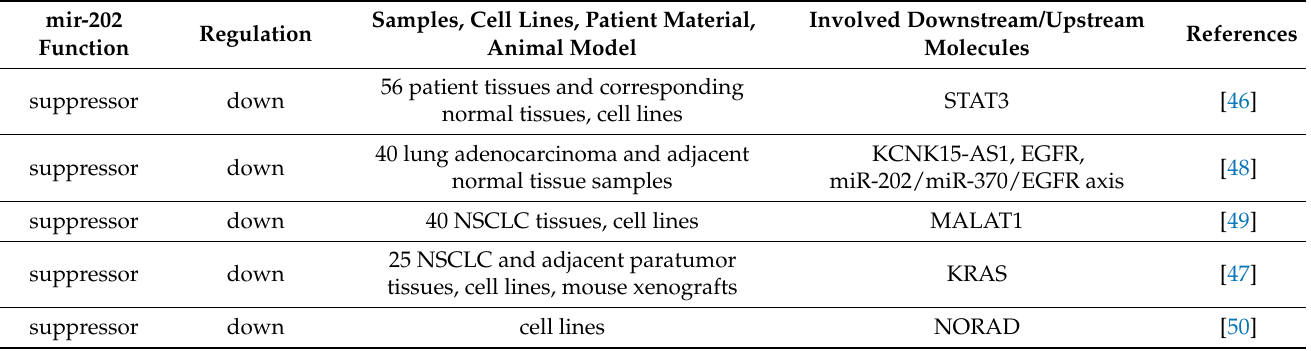
Table 3. miR-202 is a potential tumor suppressor in lung